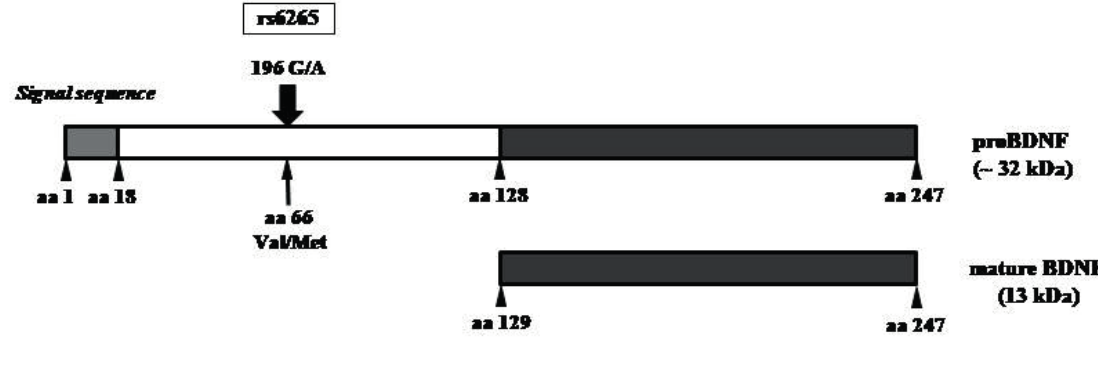
Figure 1. Structure of proBDNF and mature BDNF. Arrowheads indicate known protease cleavage sites involved in the processing to mature BDNF. The position of the single nucleotide polymorphism (rs6265, Val66Met) in human BDNF is indicated by arrows. This figure was modified from Zhang